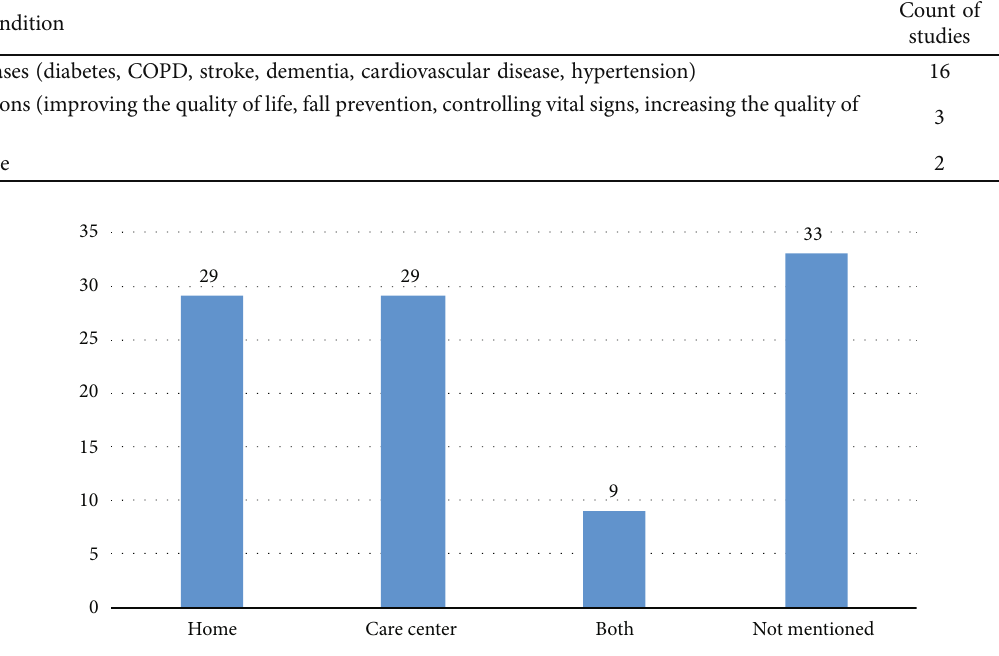
Figure 5: The places that elderly personalized mobile apps were